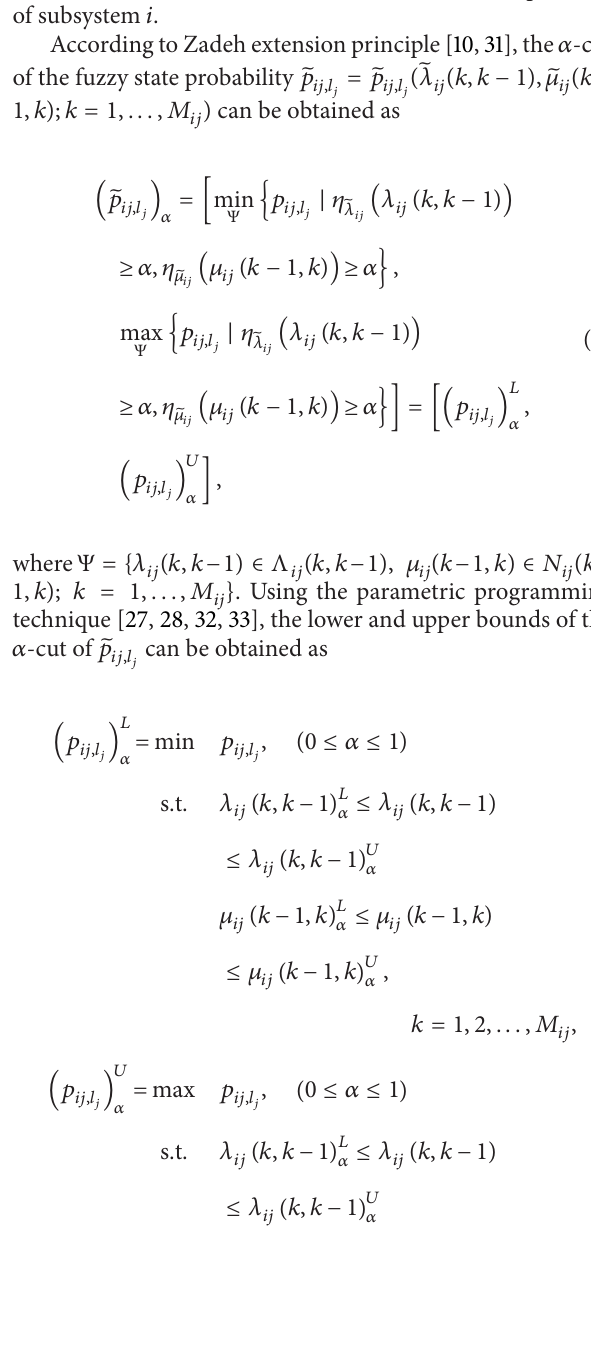
Figure 2: The state-transition diagram for the component 𝑗 of subsystem 𝑖